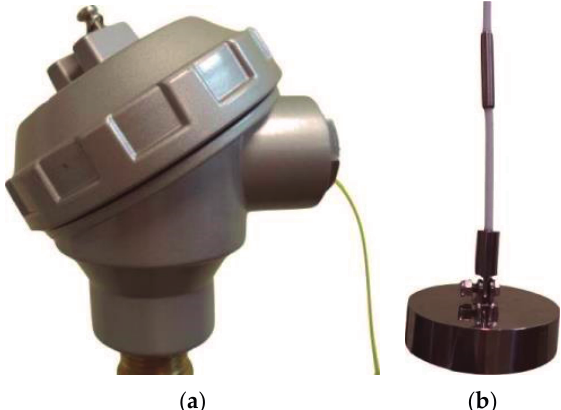
Figure 8. Photo of the ( a ) mounting head; and ( b ) anchor attached to the sensor.